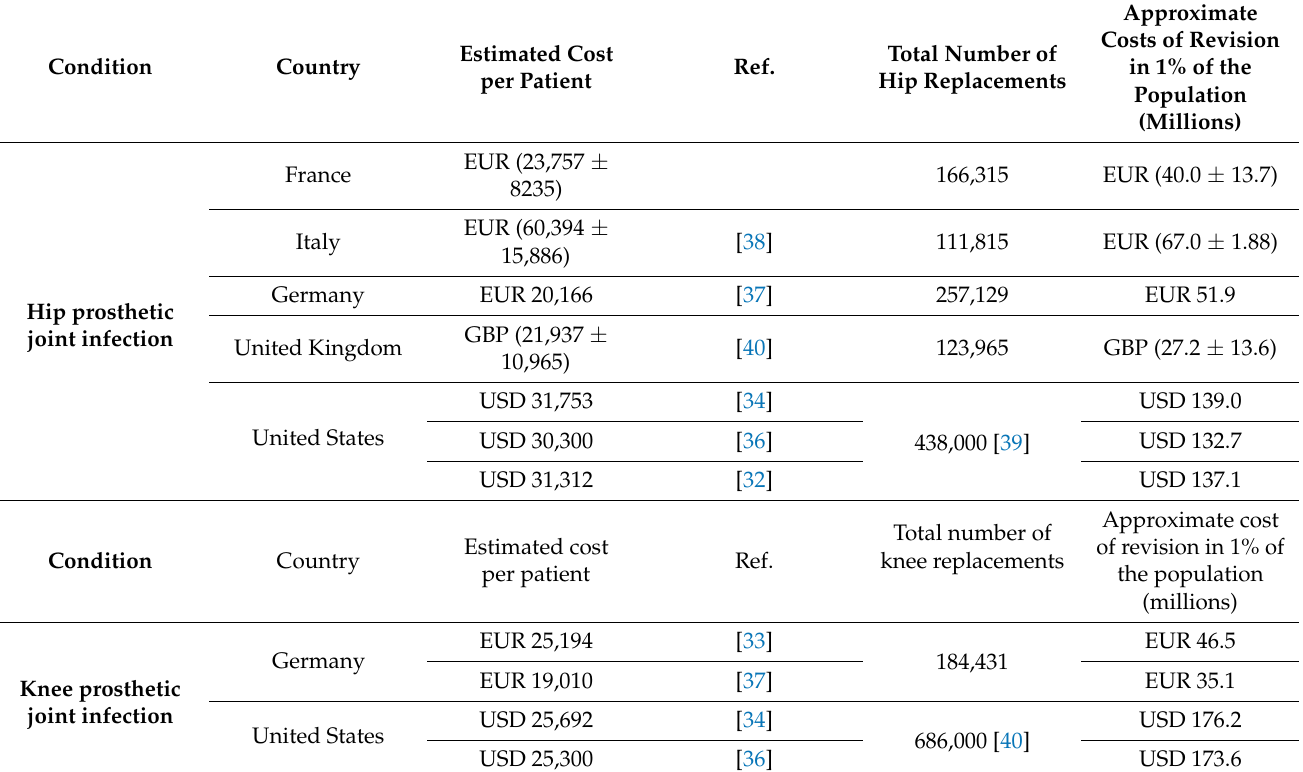
Table 2. Estimated hospital costs for revision surgery after hip or knee prosthetic joint infection in Europe and the United States, adopted after Roman ò et al. [15]. The number of hip replacements and total knee replacements for European countries were obtained from Table 1. The approximate costs were then calculated by multiplying the data given